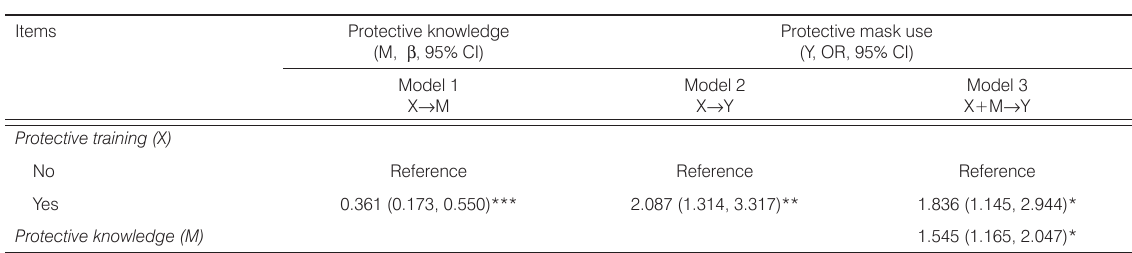
Table 3. Association between protective training regarding AD exposure, protective knowledge, and using protective